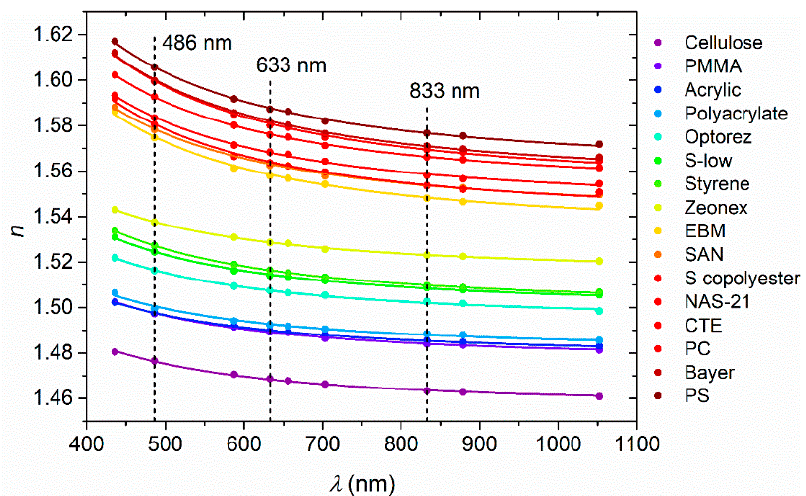
Figure A1. Dispersion curves for 16 OPs (see legend), obtained by fitting experimental n data (symbols) extracted from reference [12], with Cauchy equation (equation 1) with two coefficients. The flowchart of the program for calculating the refractive index n and thickness h of optical polymer (OP) films from transmission spectra in the visible and NIR is shown in Figure A2.